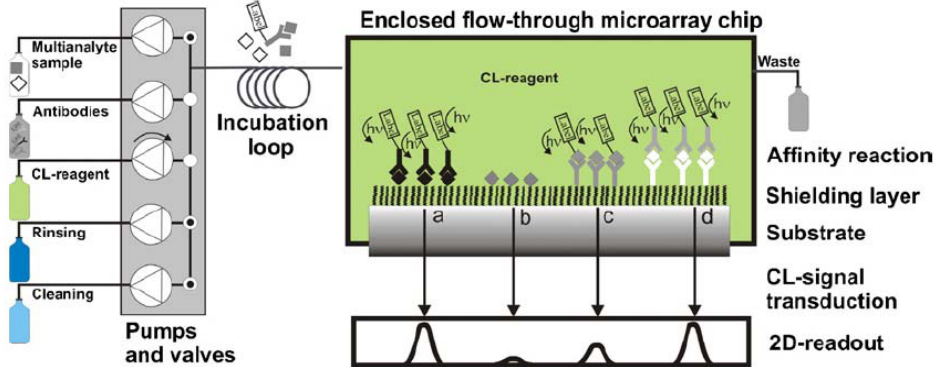
Figure 4. Schematic set-up of an analytical CL flow-through microarray platform for quantifying of analytes with indirect (a and b), direct (c), and sandwich (d) assay formats. (Reprinted from [72] © 2008 Elsevier